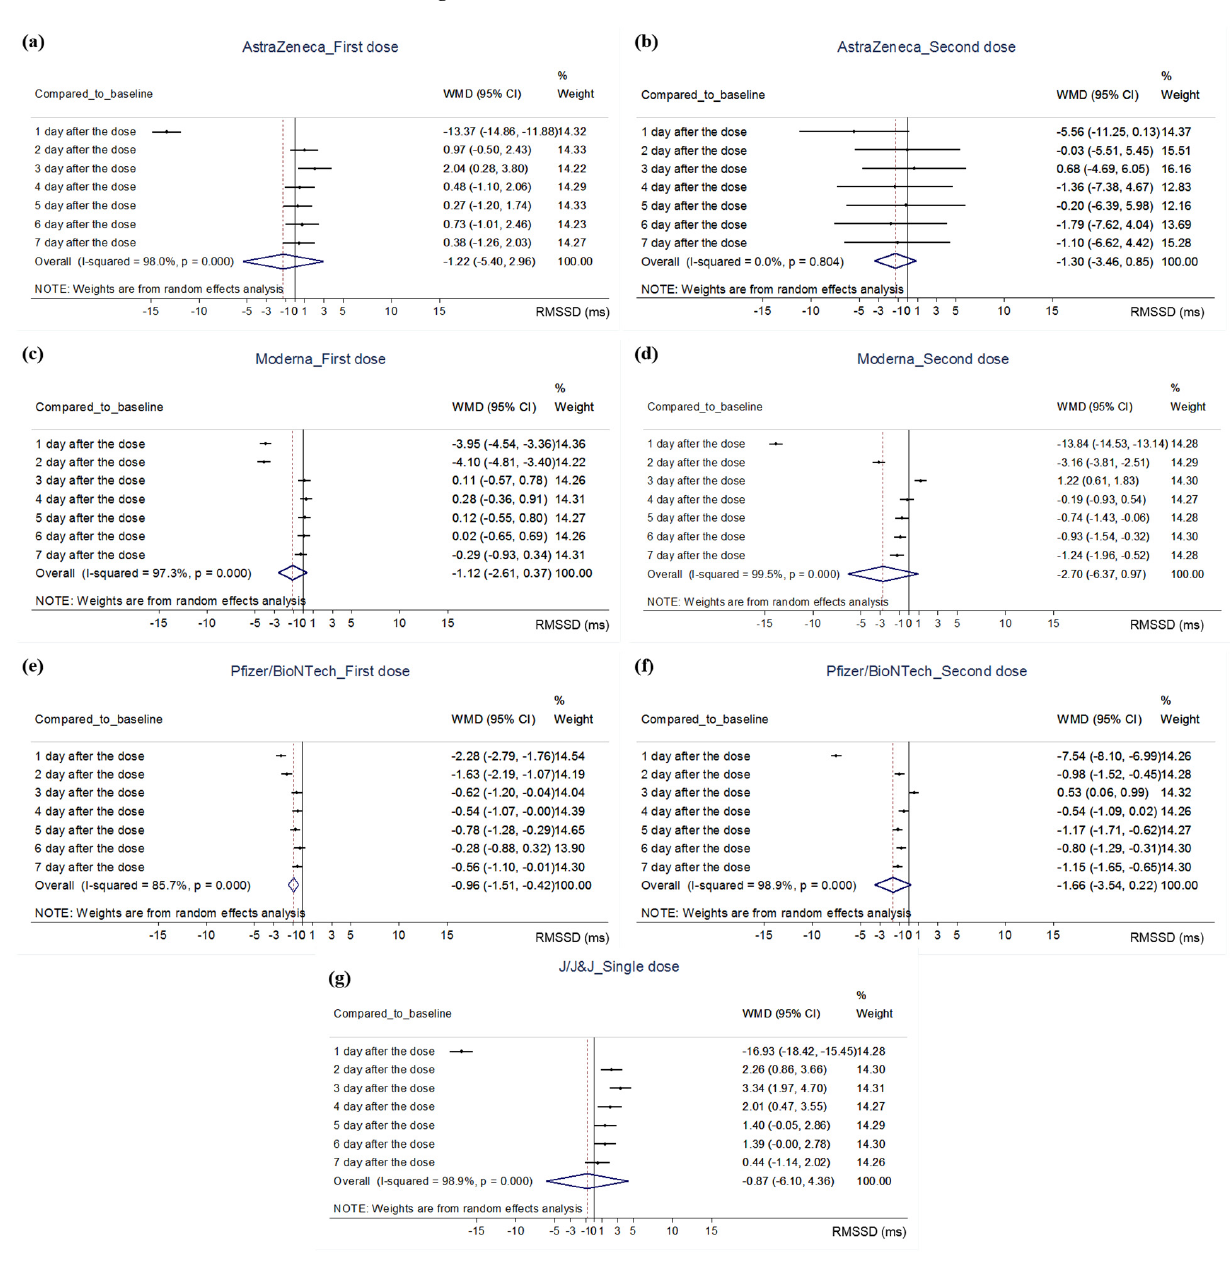
Figure 2. Meta-analysis on the data from Presby et al. (2022). Abbreviations. CI, confidence interval; J/J&J, Johnson & Johnson’s Janssen; RMSSD, the square root of the mean squared differences of successive NN intervals; WMD, weighted mean difference. Note. ( a ) the impact of the first dose of the AstraZeneca vaccine on RMSSD, ( b ) the impact of second dose of the AstraZeneca vaccine on RMSSD, ( c ) the impact of first dose of the Moderna vaccine on RMSSD, ( d ) the impact of the second dose of the Moderna vaccine on RMSSD, ( e ) the impact of the first dose of the Pfizer/BioNTech vaccine on RMSSD, ( f ) the impact of the second dose of the Pfizer/BioNTech vaccine on RMSSD, ( g ) the impact of single dose of J/J&J vaccine on RMSSD.